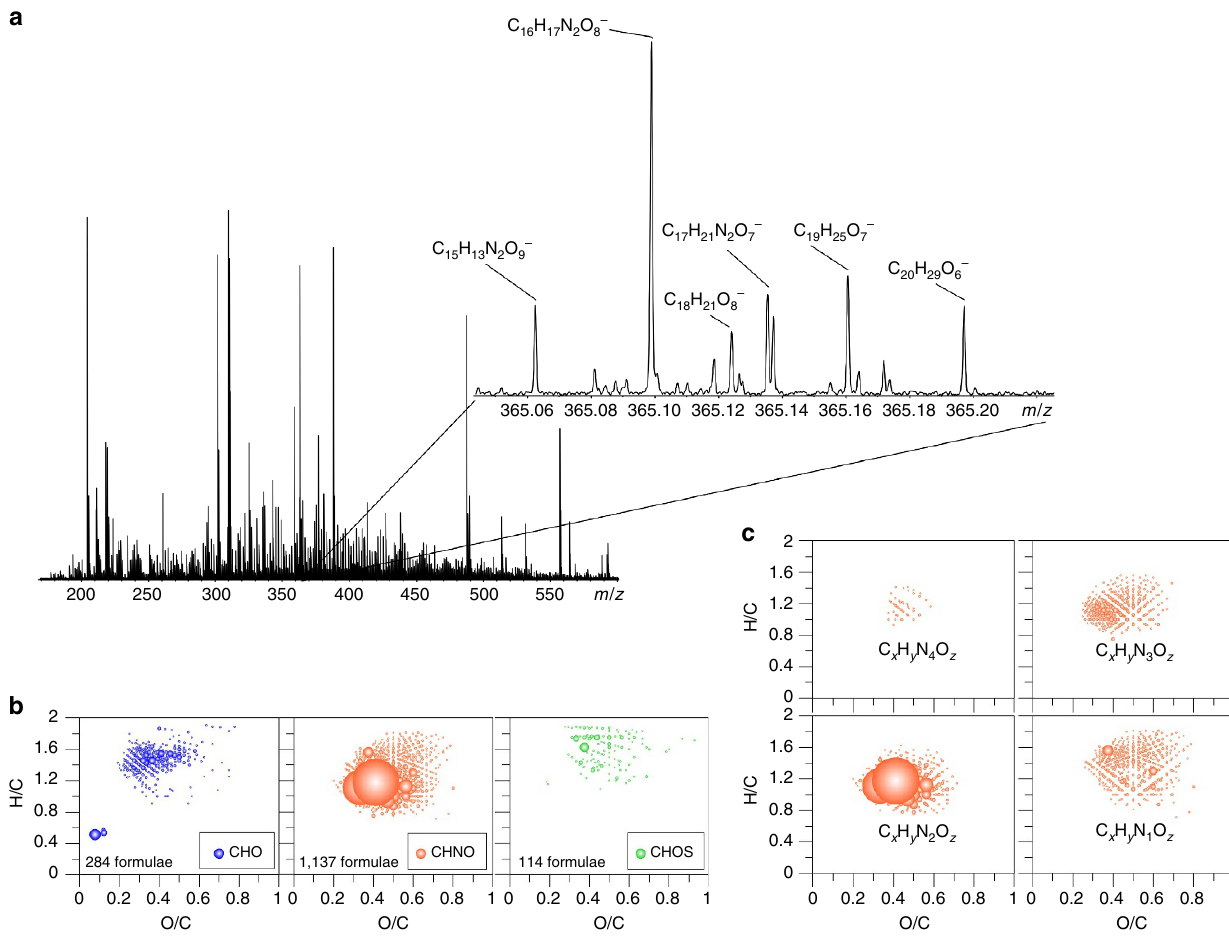
Figure 5 | Ultrahigh resolution mass spectrum of Synechococcus DOM. ( a ) Fourier transform ion cyclotron resonance mass spectrum of Synechococcus SPE-DOM, ( b ) van Krevelen diagram of all assigned molecular formulas of Synechococcus (CB0101) SPE-DOM and ( c ) van Krevelen diagrams of the distribution of CHNO formulas. Note: size of bubbles represents relative